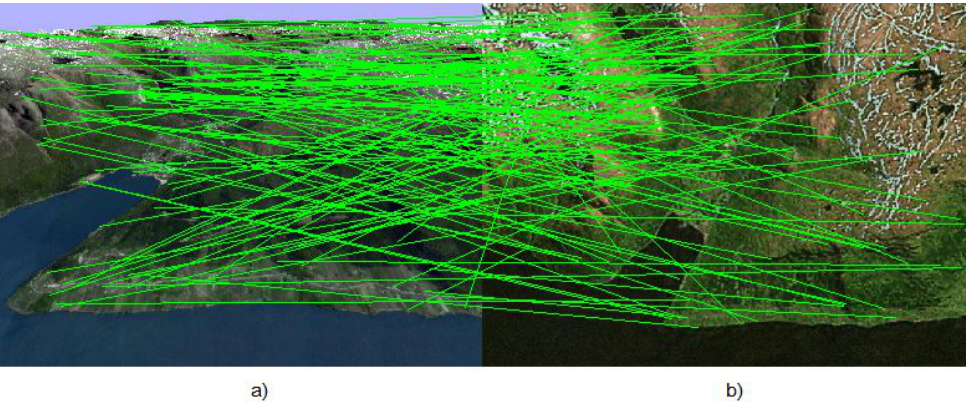
Figure 4. Correspondence between ( a ) (image I c of the on-board camera of the UAV) and ( b ) (template image loaded in the UAV memory in advance) feature points found without the UAV motion model. One can observe chaotic correspondence, which gives a huge number of outliers.